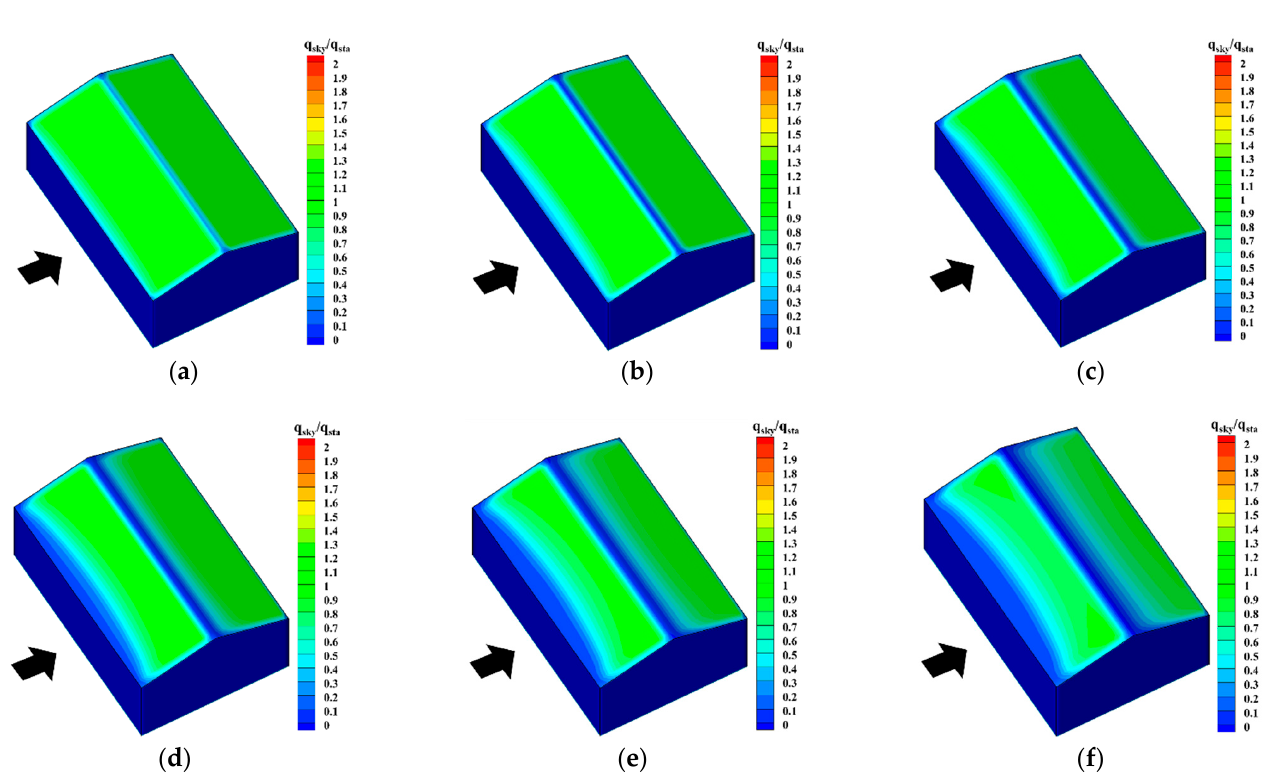
Figure 15. Normalized deposition flux of falling snow q sky / q sta : ( a ) U H = 2 m/s; ( b ) U H = 3 m/s; ( c ) U H = 4 m/s; ( d ) U H = 5 m/s; ( e ) U H = 6 m/s; ( f ) U H = 7 m/s.